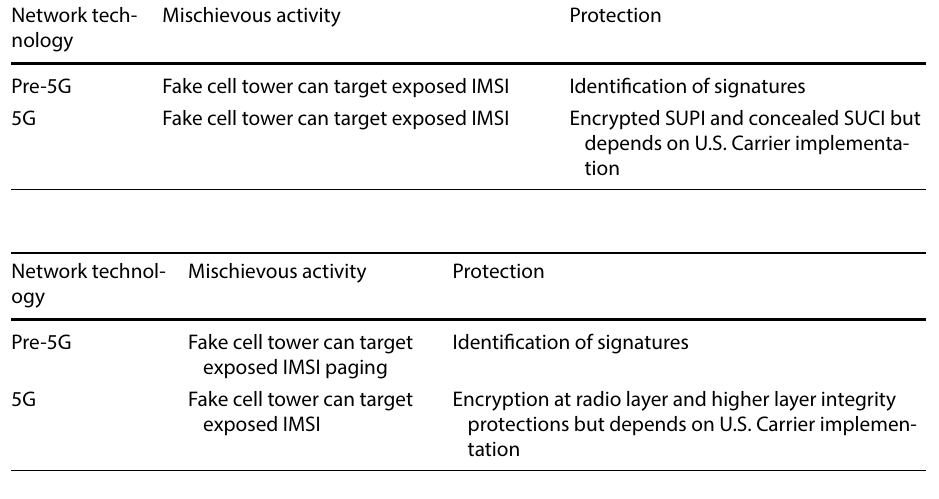
Table 7 Subscriber identity control correctness